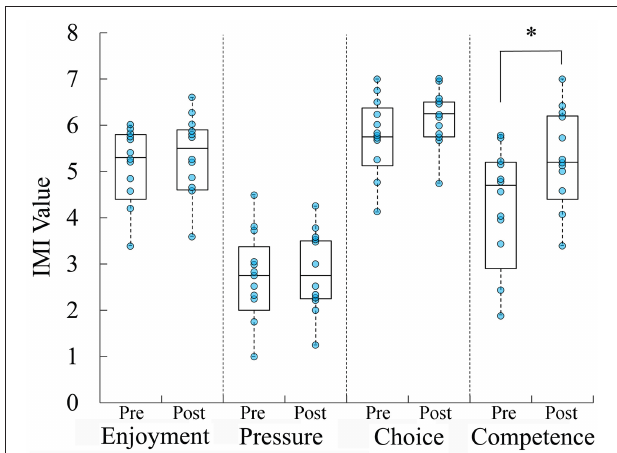
FIGURE 3 | Boxplots overlaid with raw data of self-reported motivation to use the ADAPT-MP system. Participants reported that motivation to use ADAPT-MP significantly increased over the course of the study, due to their increasing competence. * p < 0.05.